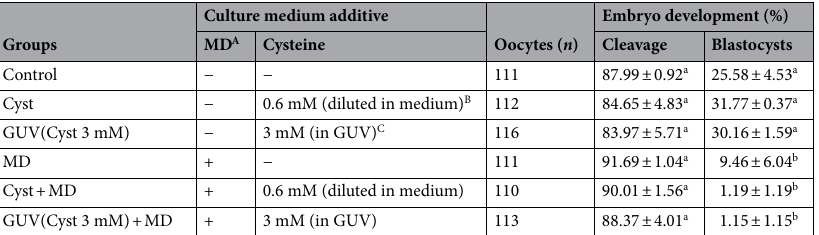
Table 3. Cleavage and development of bovine embryos cultured in vitro in medium supplemented with giant unilamellar vesicles (GUVs) and cysteine (Cyst) and subjected to menadione (MD)-induced oxidative stress. Data are expressed as the mean ± standard error of four independent replicates. A Embryos were cultured for 7 days, and menadione (5.0 μM) was included in the medium only on the sixth day of culture (from D6 to D7). B In the Cyst and Cyst + MD groups, cysteine was diluted directly into the culture medium at the final concentration of 0.6 mM. C In the GUV(Cyst 3 mM) and GUV(Cyst 3 mM) + MD groups, the GUVs were electroformed in a solution containing 3 mM cysteine (5X solution) and subsequently diluted in the culture medium (20% v/v) in order to obtain a maximum final concentration of cysteine in the medium of 0.6 mM after complete content release from the GUVs. ab Different letters in each column indicate significant differences ( P < 0.05).